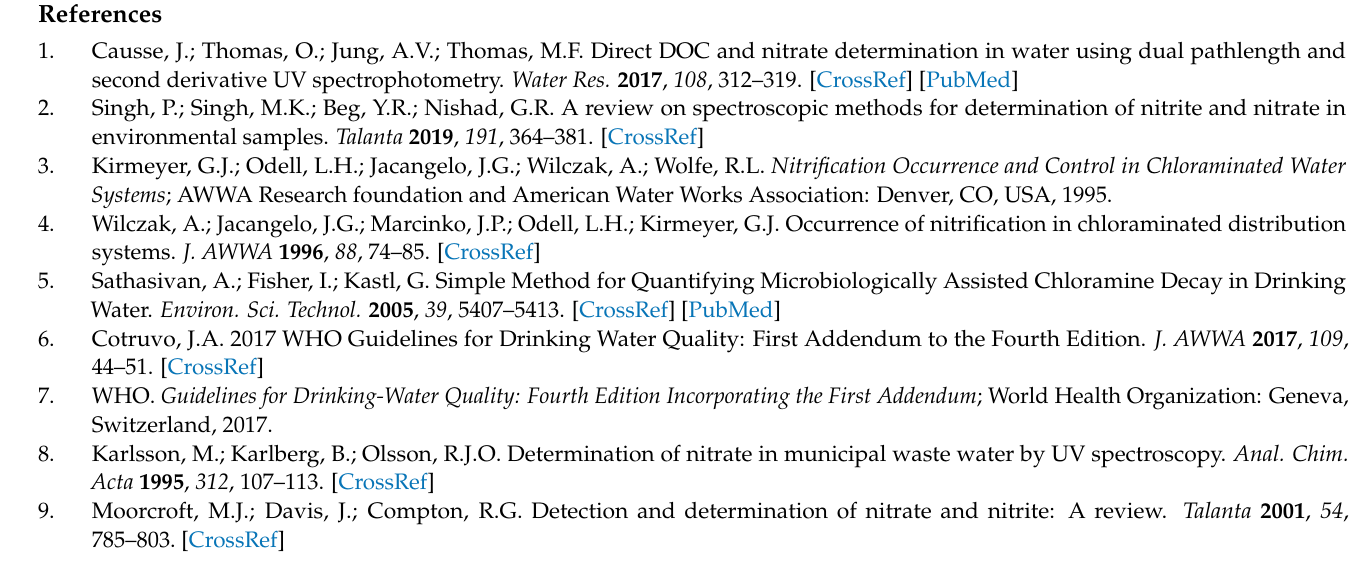
Figure A1. Plot of predicted and lab relative NOx concentrations: ( a ) Sample1; ( b ) Sample2; ( c ) Sample3; ( d ) Sample4; ( e ) Sample5; ( f ) Sample6.